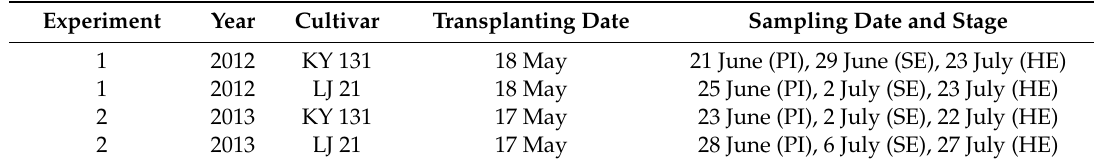
Table 1. Details of nitrogen (N) rate experiments with two rice cultivars conducted during 2012–2013.